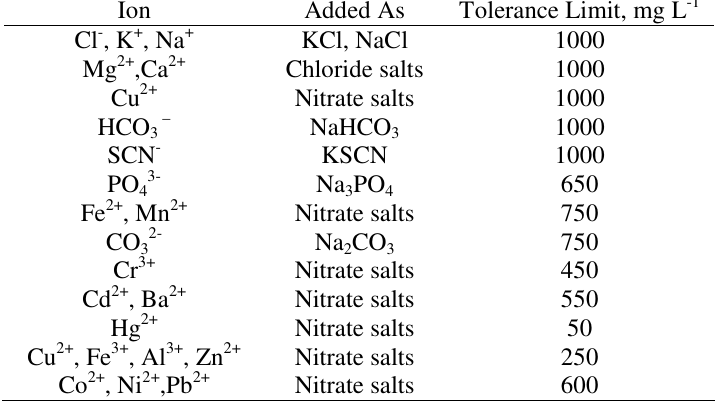
Table 1. Effects of the matrix ions on the recoveries of the examined silver ion (N=6)